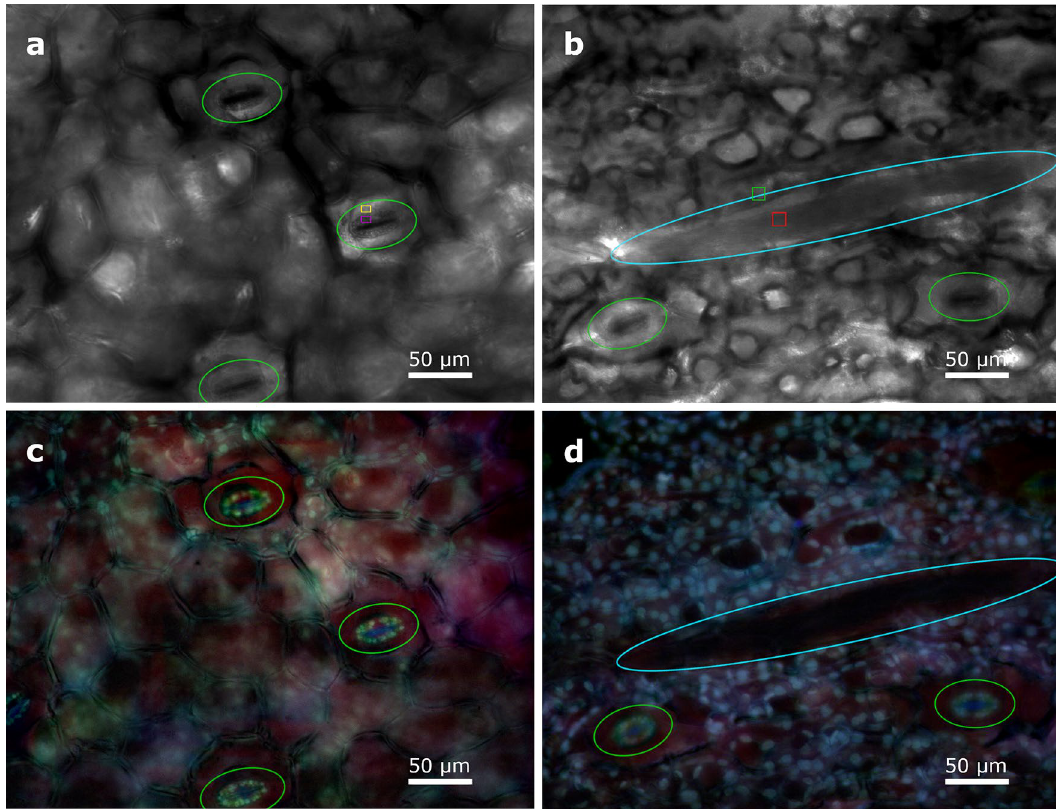
Figure 5. Images of Epipremnum aureum stomata obtained with a phase ( a ) and a fluorescence ( c ) microscope. Images of an Epipremnum aureum inulin raphide, obtained with the same phase and fluorescence microscopes ( b , d ),